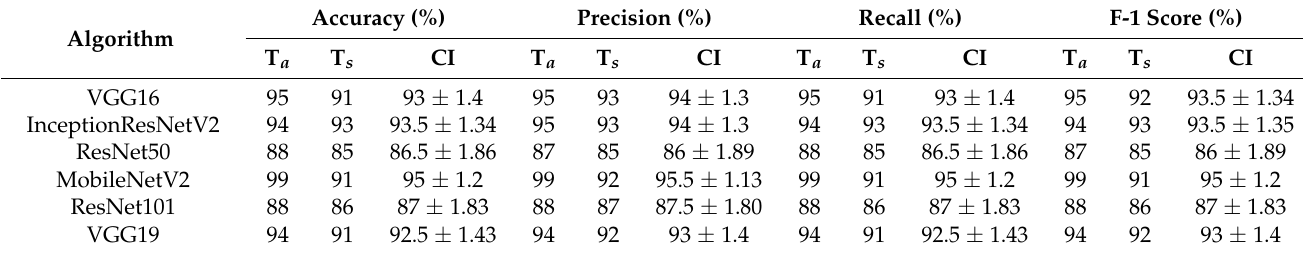
Table 3. COVID-19 screening performance of all models using a mixed dataset, presented with 95% confidence intervals (CI, α = 0.05). T a —Training Set; T s —Test Set.